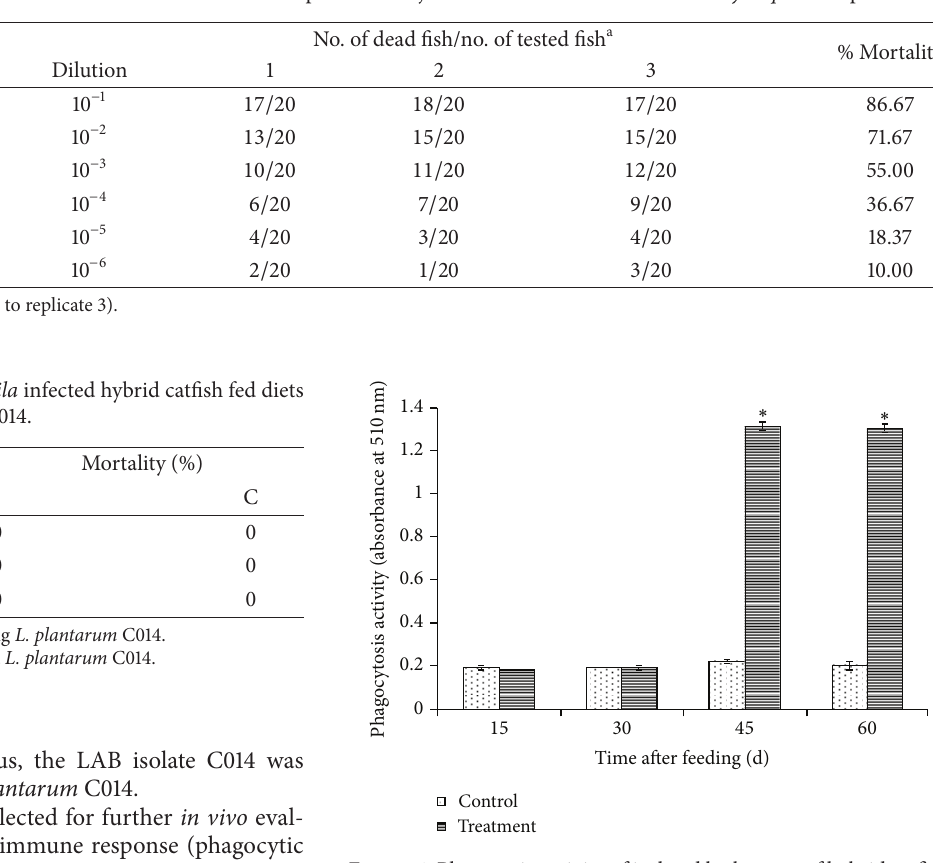
Figure 1: Phagocytic activity of isolated leukocytes of hybrid catfish fed diets with (treatment group) and without (control group) L. plantarum C014. Results were presented as means ± SD of triplicate observations. Significant differences ( 𝑃 < 0.05 ) from the control group of the same day are indicated by